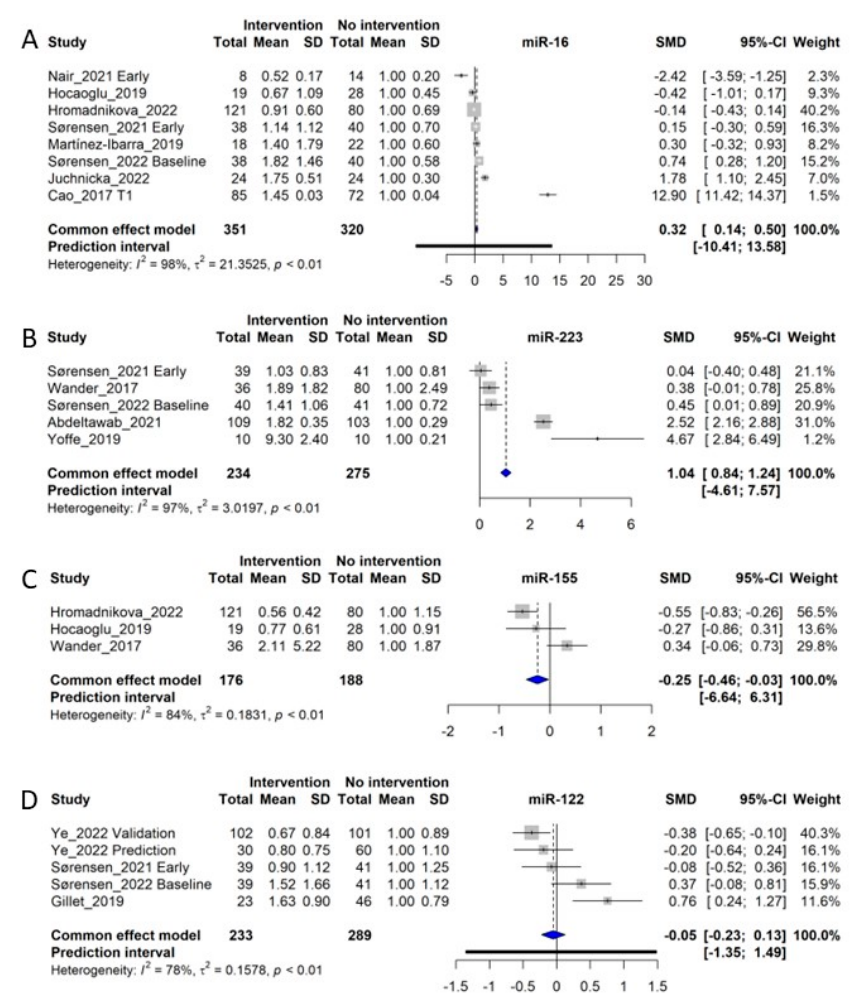
Figure 5. Forest plots of the fixed-effect meta-analysis of ( A ) miR-16 [9,20–22,30,33,36,43], ( B ) miR-223 [20,21,23,28,31], ( C ) miR-155 [28,33,43], and ( D ) miR-122 [19–21,41].